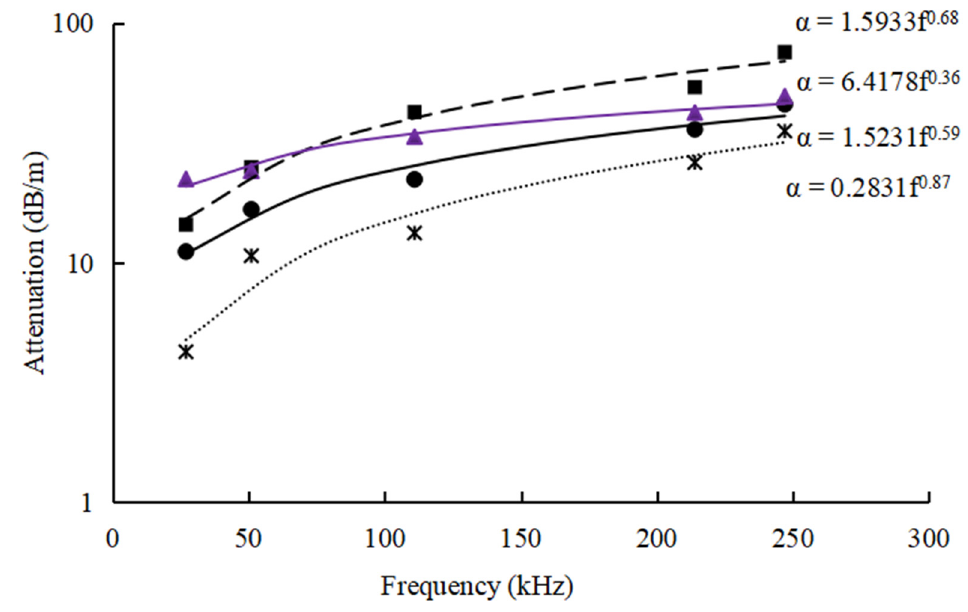
Figure 4. The attenuation dispersion of different sediments. The black ◾ dots are silty sand, the black ● dots are silt, the black ∗ dots are silty clay in SCS, and the purple ▲ is clayey silt in WP.